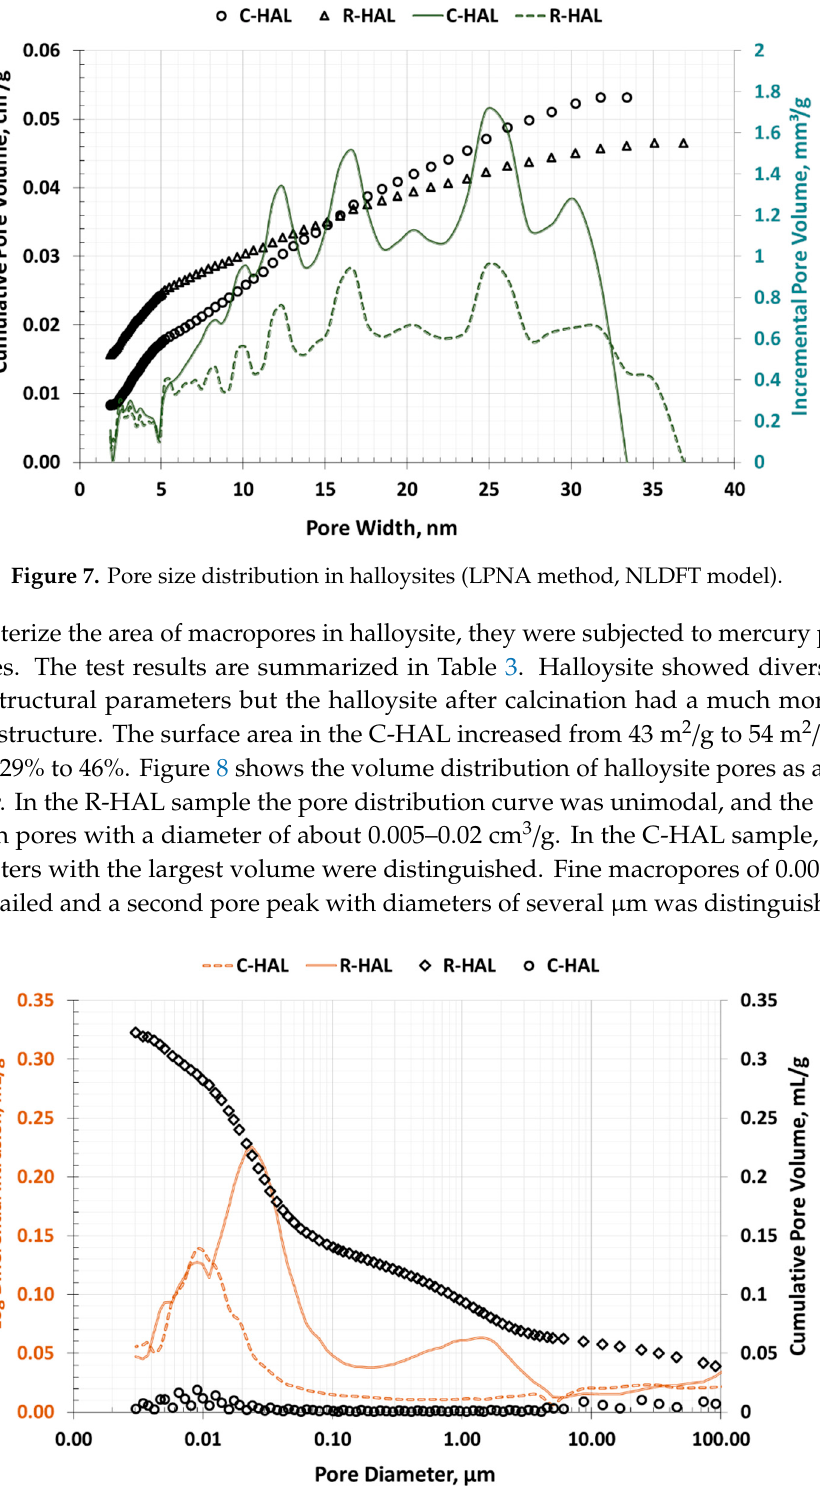
Figure 6. Distribution of pore volume as a function of their diameter in halloysites (LPNA method, BJH model) .